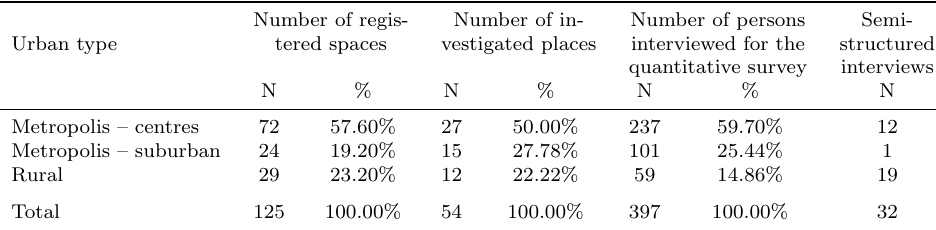
Table 1: Data collection process according to urban environments